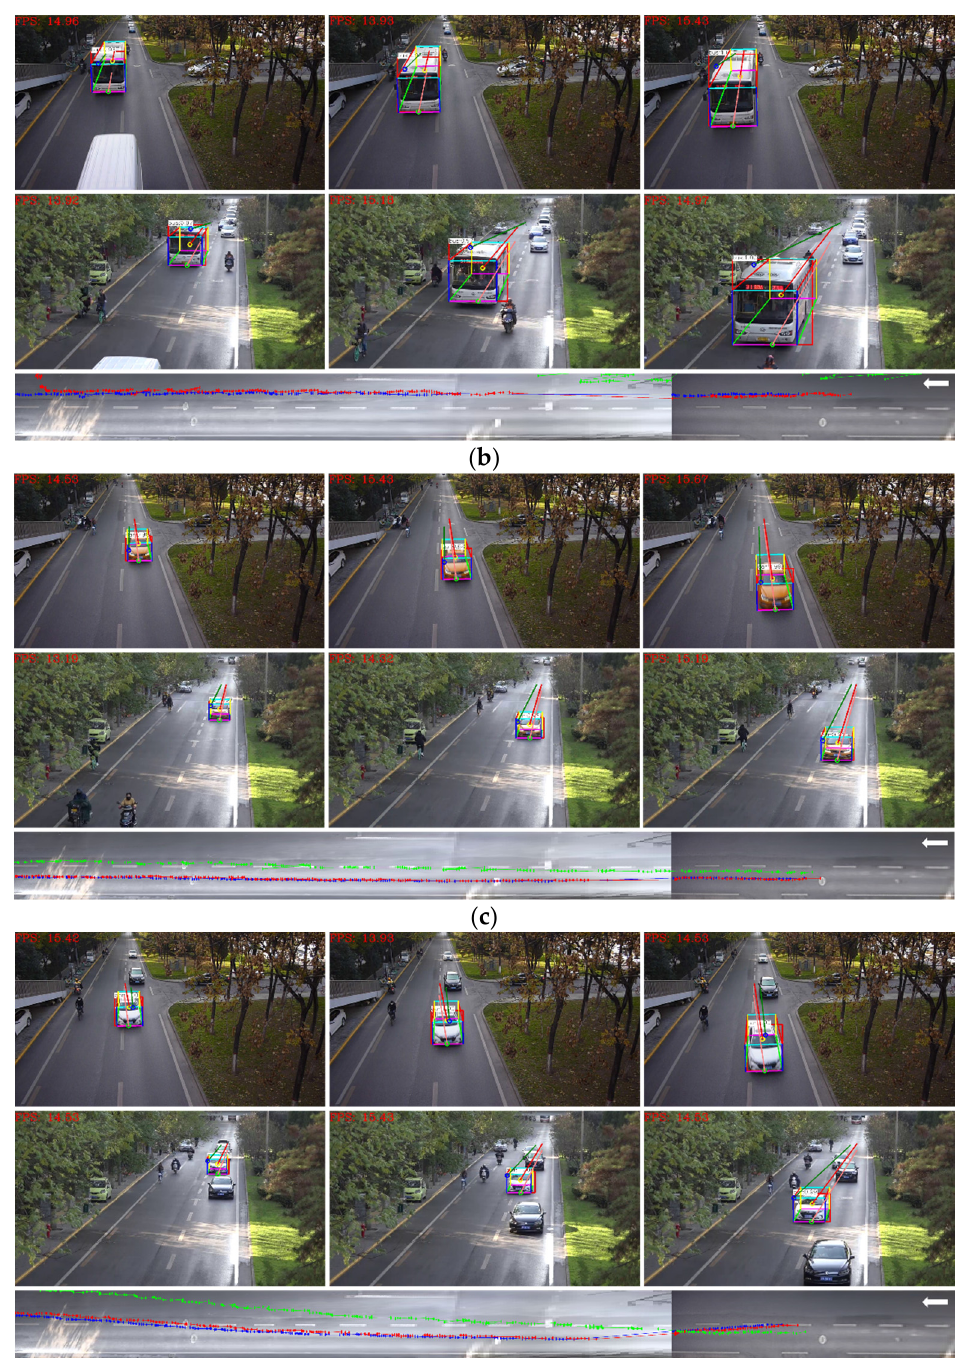
Figure 16. Comparison examples of different 3D trajectory extraction algorithms. ( a ) Comparison example 1; ( b ) Comparison example 2; ( c ) Comparison example 3; ( d ) Comparison example 4. Table 8. Comparison of different 3D trajectory extraction algorithms.